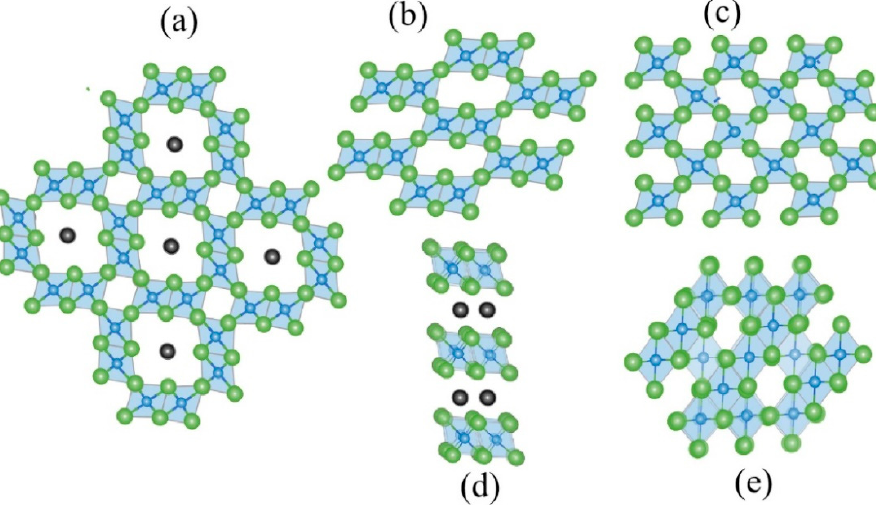
Table 1. Manganese oxide removal thallium performance and advantages and